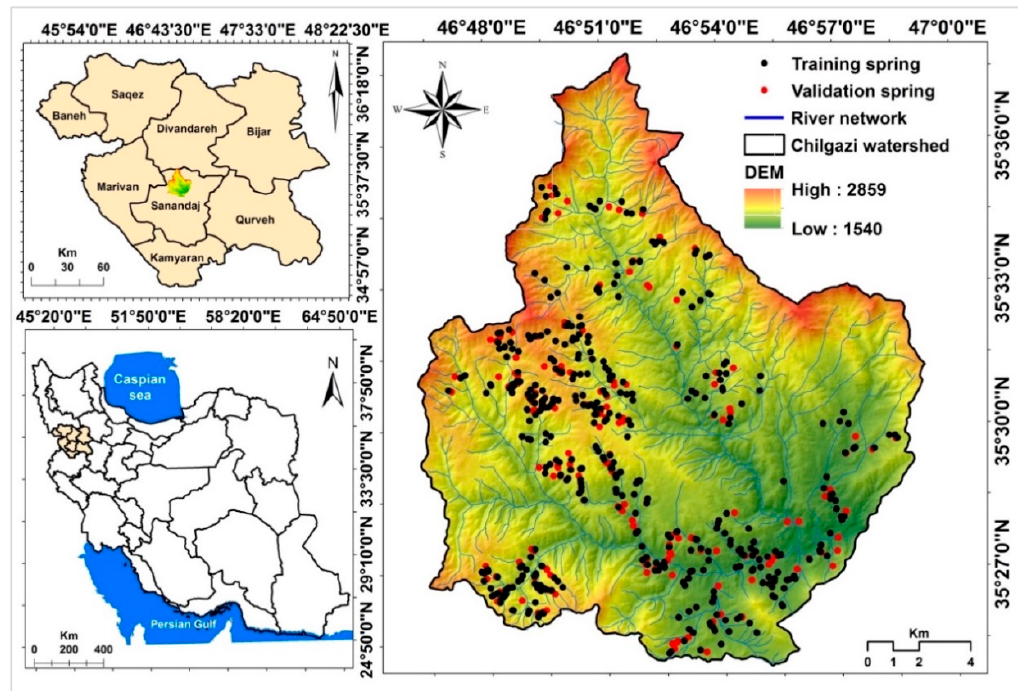
Figure 1. Location of the research area and groundwater springs.